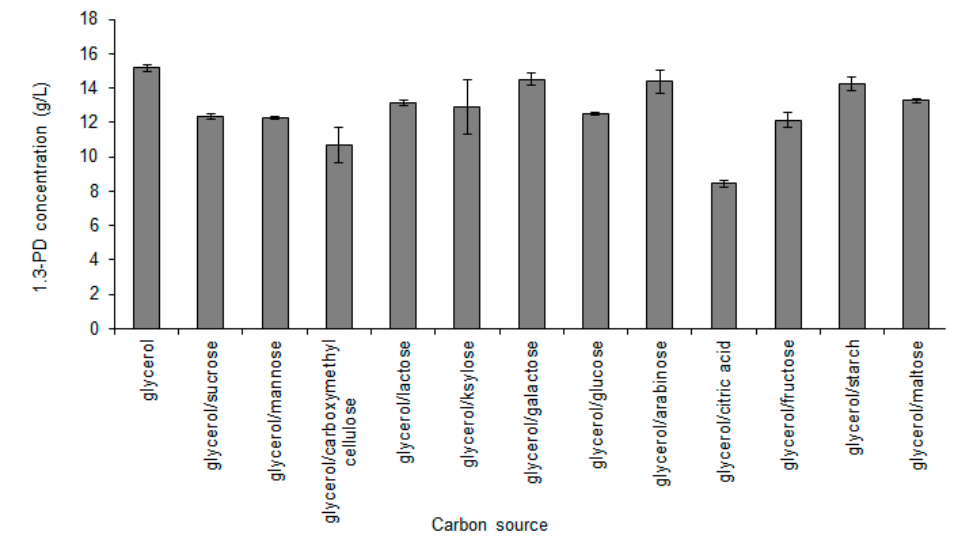
Figure 3. Effects of co-substrates addition on 1,3-PD production by C. freundii AD119.